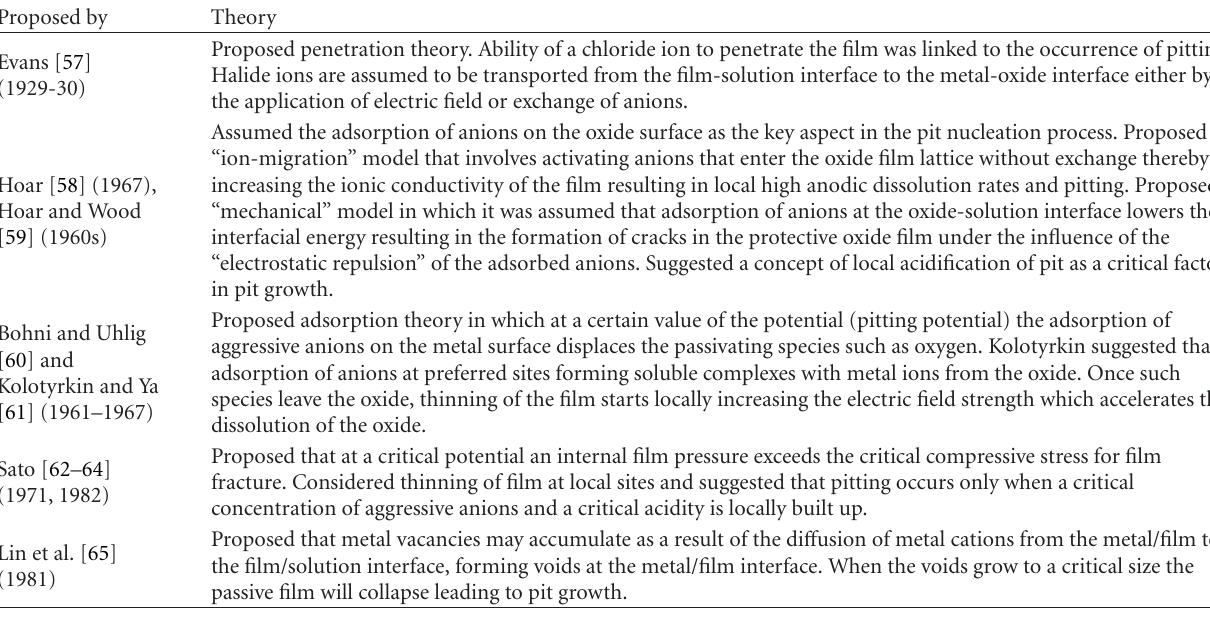
Table 4: Pit nucleation